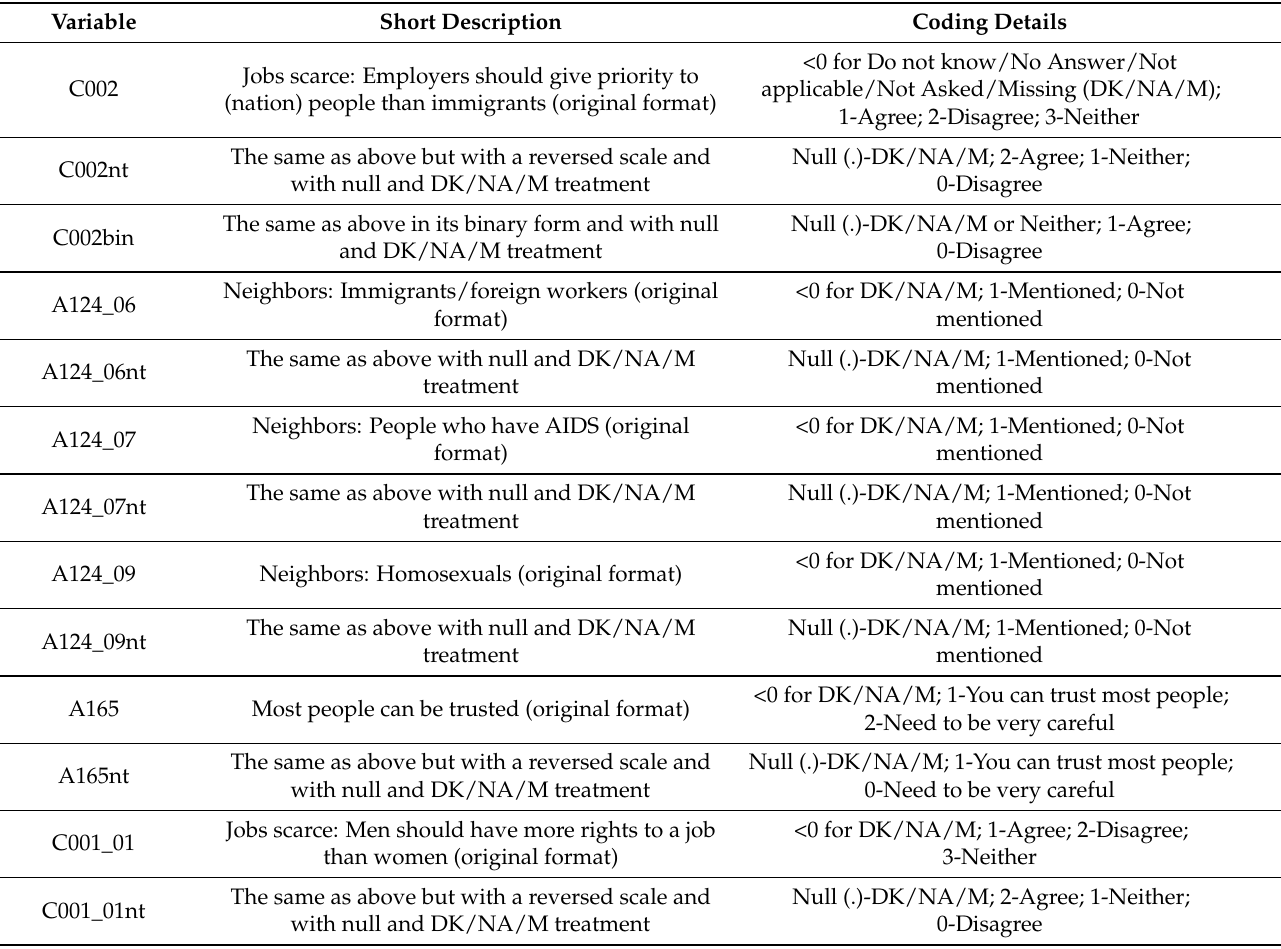
Table A1. The most relevant items of this study. Variable Short Description Coding